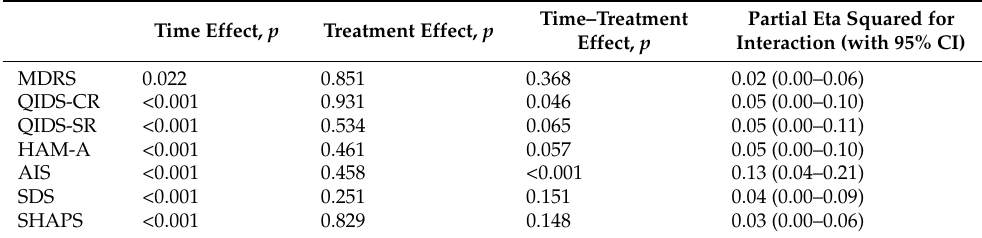
Table 4. Results of the mixed-effect model, with the duration of previous psychiatric treatment as a covariate, showing the significance levels and effect sizes (partial eta squared) for all outcomes. MADRS—Montgomery–Åsberg Depression Rating Scale; HAM-A—Hamilton Anxiety Rating Scale; QIDS-CR—Quick Inventory of Depressive Symptomatology, clinician rating; QIDS-SR—Quick In- ventory of Depressive Symptomatology, self rating; SHAPS—Snaith–Hamilton Pleasure Scale; and AIS—Athens Insomnia